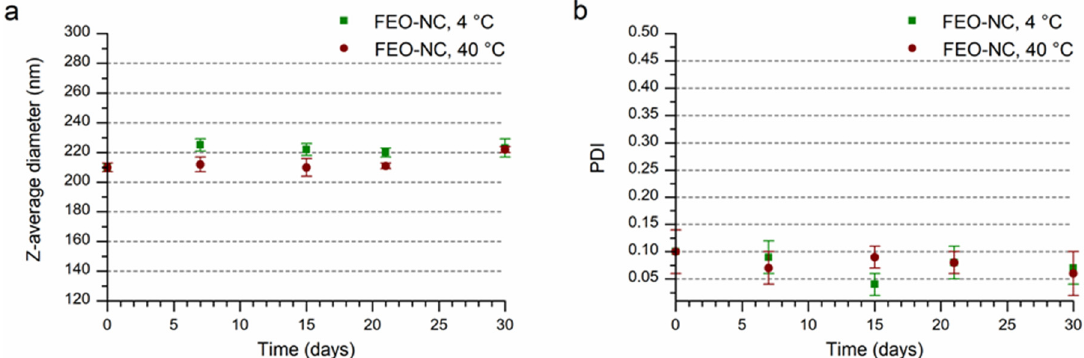
Figure 1. Z-average diameter ( a ) and PDI ( b ) of FEO-NCs over time (storage at 4 and 40 °C).